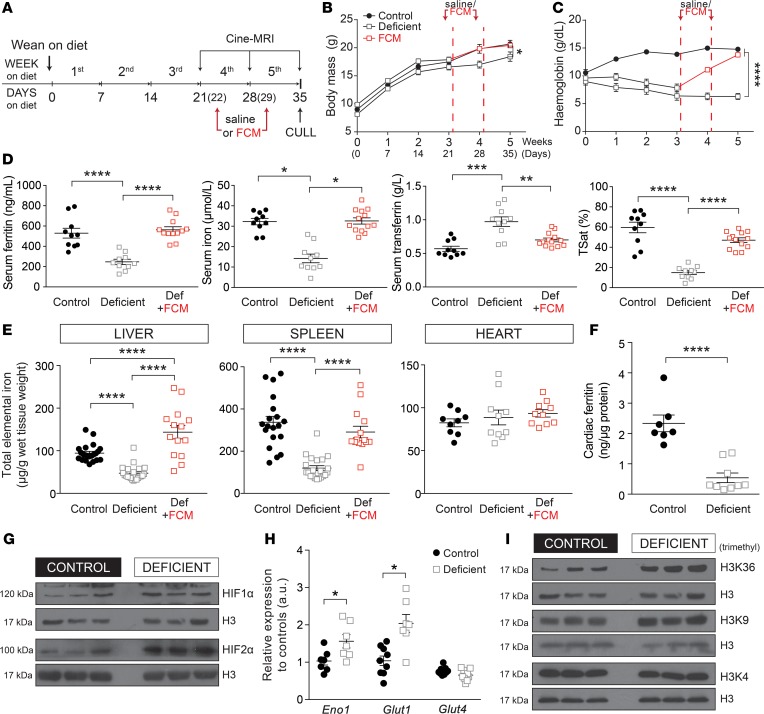
Characterizing the murine model of iron deficiency.(A) Timeline of the experimental protocol for establishing dietary iron deficiency in 3-week-old mice, showing time points at which either FCM or saline is injected, MRI scanning is performed, and hearts are excised for further studies. (B) Body mass and (C) tail vein blood hemoglobin concentration were measured during the 5-week dietary intervention (n = 6 animals/group). (D) Ferritin, iron, transferrin, and transferrin saturation (TSat) measured in the serum after 5 weeks of diet. n > 10 animals/group. (E) Elemental iron content in lysates of the liver, spleen, and heart, normalized to wet tissue weight, after 5 weeks of diet. n > 10 animals/group. (F) Cardiac ferritin expression measured by ELISA after 5 weeks of diet (n > 7 animals/group). (G) Immunoblot for HIF1α and HIF2α in cardiac lysates, normalized to histone H3 as the loading control, after 5 weeks of diet (n = 3 animals/group). (H) RT-qPCR analysis of mRNA levels of the HIF target genes Eno1 and Glut1 and non-HIF target gene Glut4 after 5 weeks of diet. n = 9 animals/group. (I) Immunoblot for the histone marks H3K36, -K9, and -K4 after 5 weeks of diet (n = 3 animals/group). See Supplemental Table 1 for details of the number of experimental repeats. Note that HIF1α in G and H3K36me3 in I were blotted from the same membrane and, therefore, have the same nuclear loading control (histone H3). *P < 0.05, **P < 0.01, ***P < 0.001, ****P < 0.0001. P values determined by 2-way ANOVA for A and B; 1-way ANOVA for D and E; unpaired Student’s t test (2-tailed) for F and H.